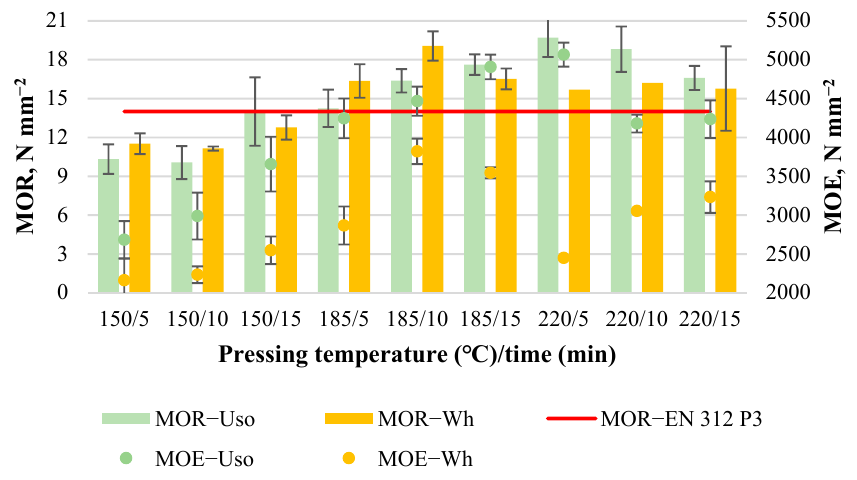
Figure 8. Bending properties of binder-less boards with a density of 1000 kg m − 3 depending on the crop and pressing variables.